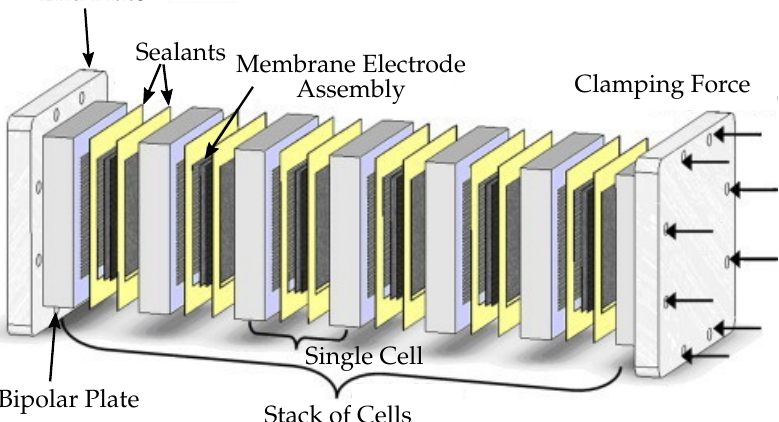
Figure 3. PEMFC stack. Reprinted from Journal of Power Sources, 194/1, Lin et al. [94], A high- efficiency assembly technique for large PEMFC stacks: Part I. Theory, 381–390, Copyright (2022), with permission from